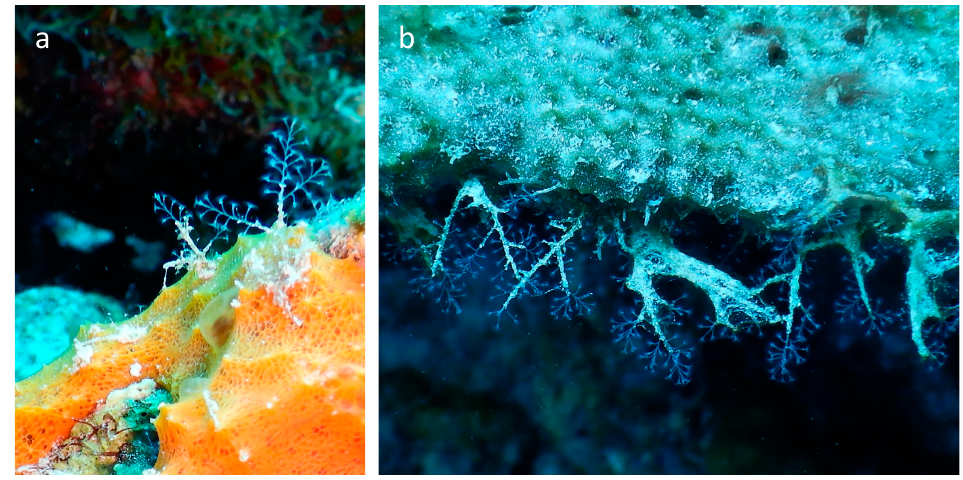
Figure 1. Two examples of the association between demosponges and Nemalecium lighti in Bonaire reef system: N. lighti associated with ( a ) Scopalina ruetzleri and ( b ) Ircinia sp. Along the west coast of the island, 16 different sites were chosen randomly based on their SCUBA shore-diving accessibility (Figure 2 and Table 1).